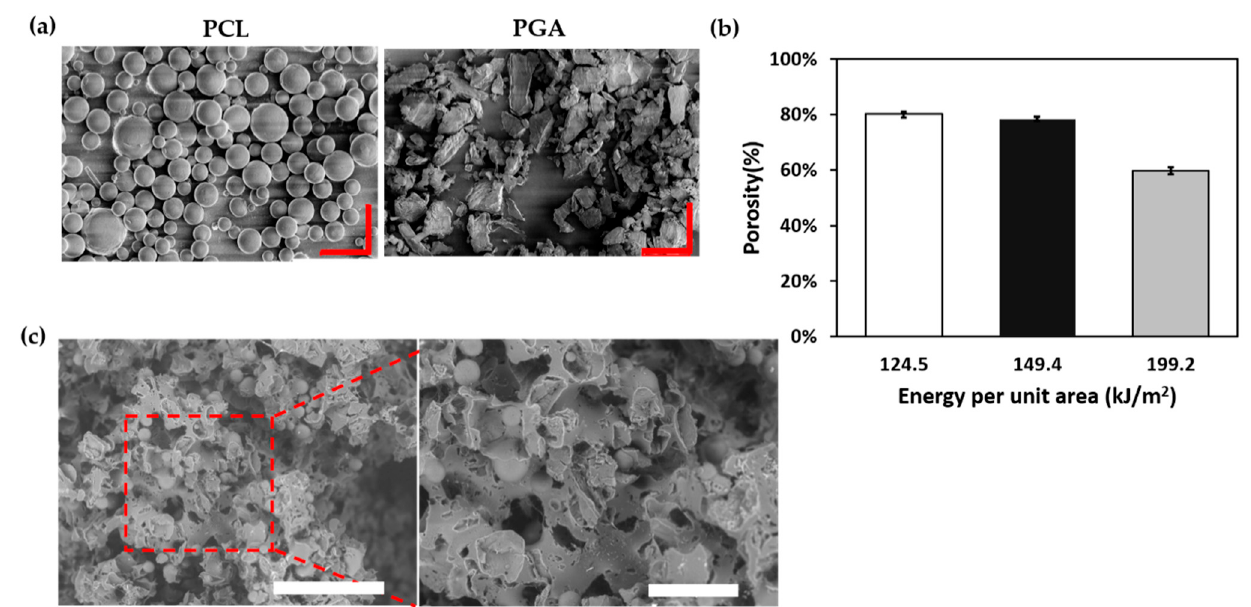
Figure 3. ( a ) Morphology of the PCL and PGA microparticle under scanning electron microscopy (SEM) (scale bar 100 µm, magnification 500×); ( b ) the % of porosity of the 3-D construct versus energy density. Each column represents mean ± SD with n = 3 independent experiments; ( c ) morphology of the macroporous scaffold after leaching out of PGA microparticle under SEM, showing the porous network (scale bar 500 µm, magnification 100× and 200 µm, magnification 200×).